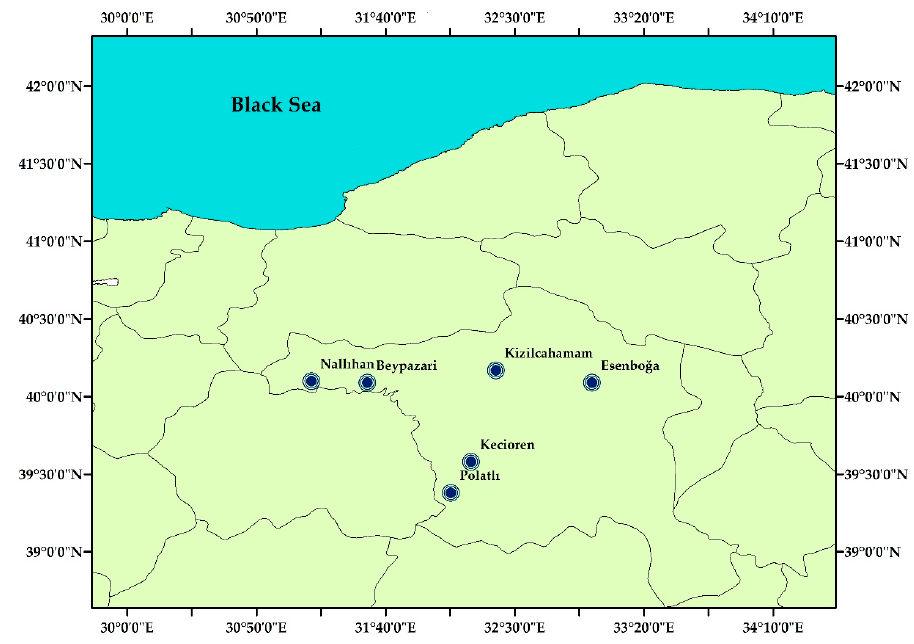
Figure 2. Locations of the six meteorological stations where the data used in this study were